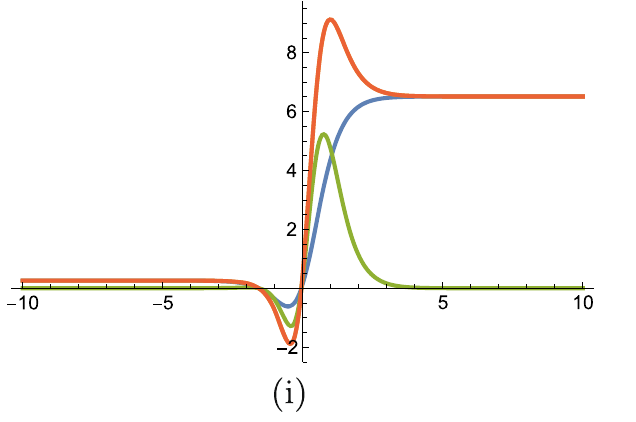
level, the geodesic motion can reach the asymptotic infinity at the outer static region. (ii) Schwarzschild black-hole type solution: K = 0 . 3, Q = 1, R 0 = 0 . 6, L null = 4. The potential is similar to that of the usual Schwarzschild black hole. For the low energy level, the geodesic motion falls into the black